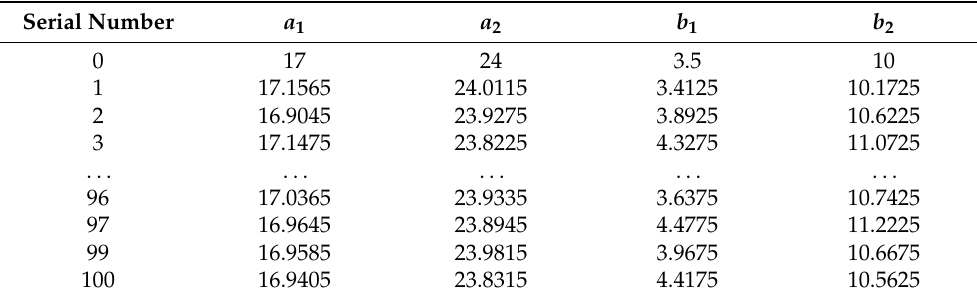
Table 3. Some sampling points correspond to design variable